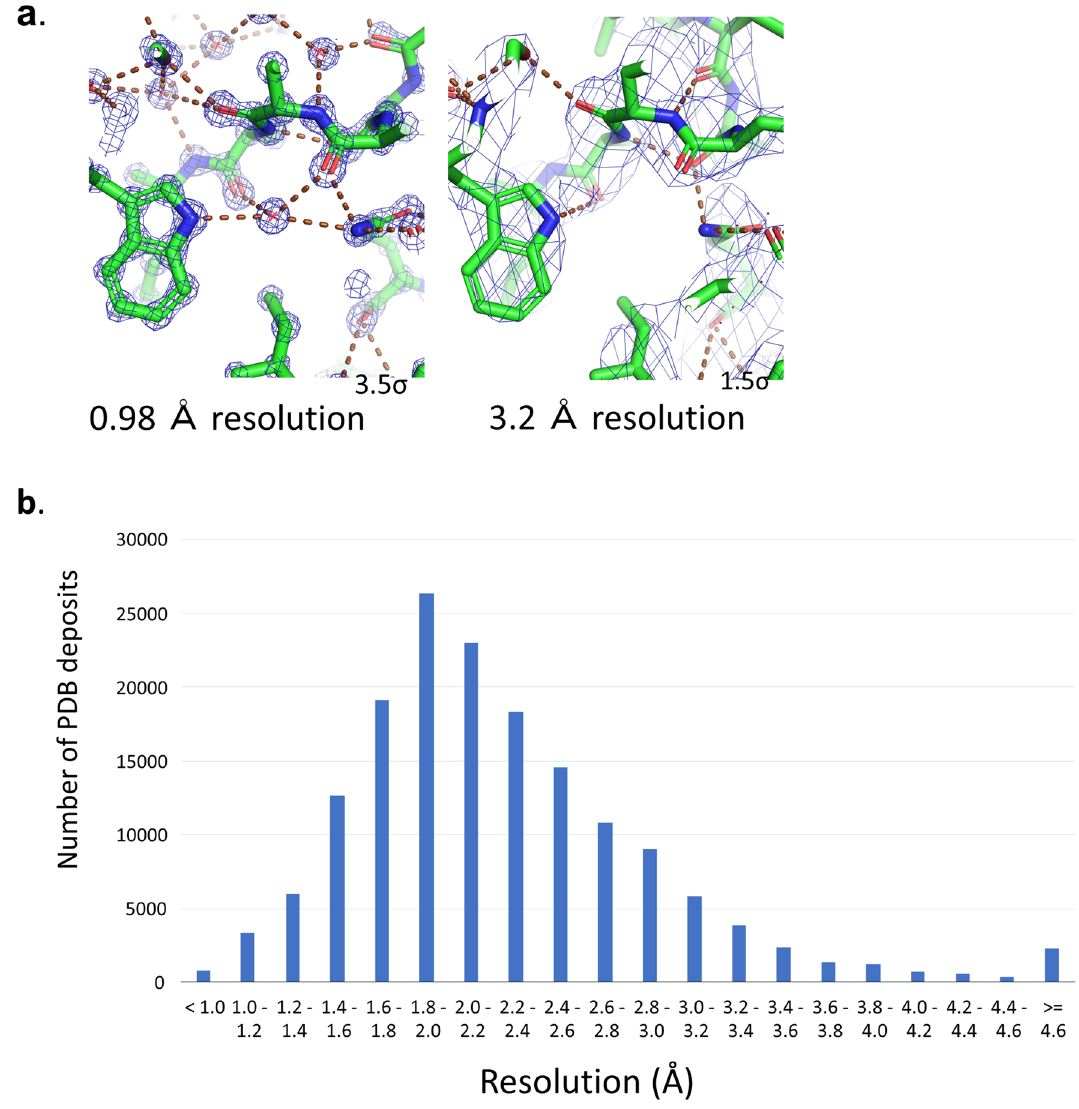
Figure 1. Challenges at low resolution. ( a ) Part of CDK2 structure at high resolution (left; PDB:6Q4G) and low resolution (right; PDB:5UQ1). Atom coordinates and electron density (2mFo-DFc or ρ obs ) calculated